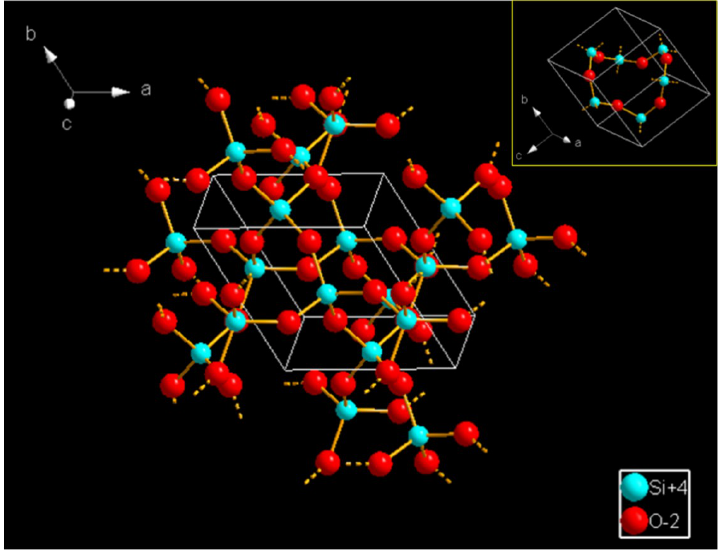
Figure 15. Schematic diagram of the crystal lattice of SiO 2.